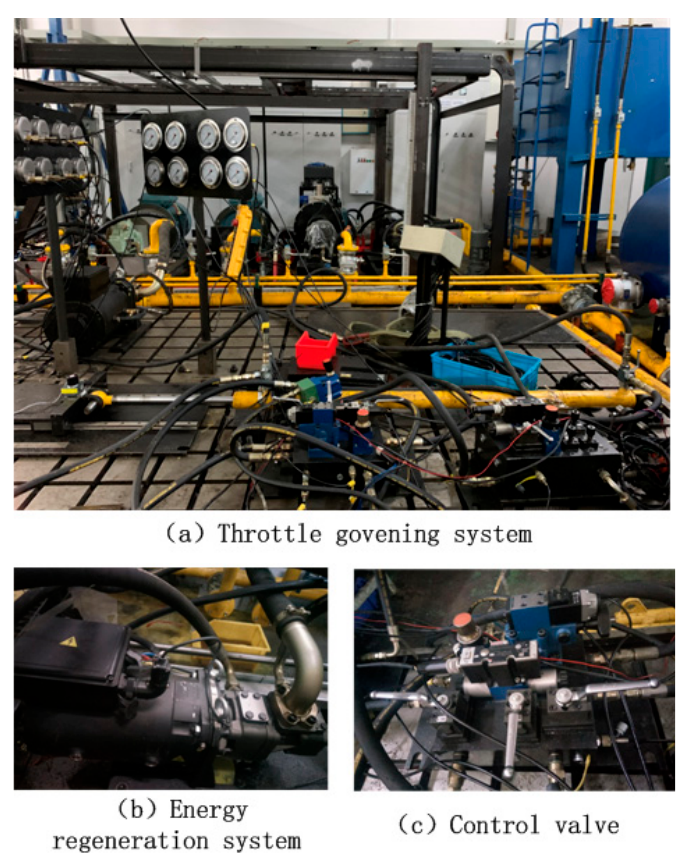
Figure 30. Partial physical diagram of the experimental platform.